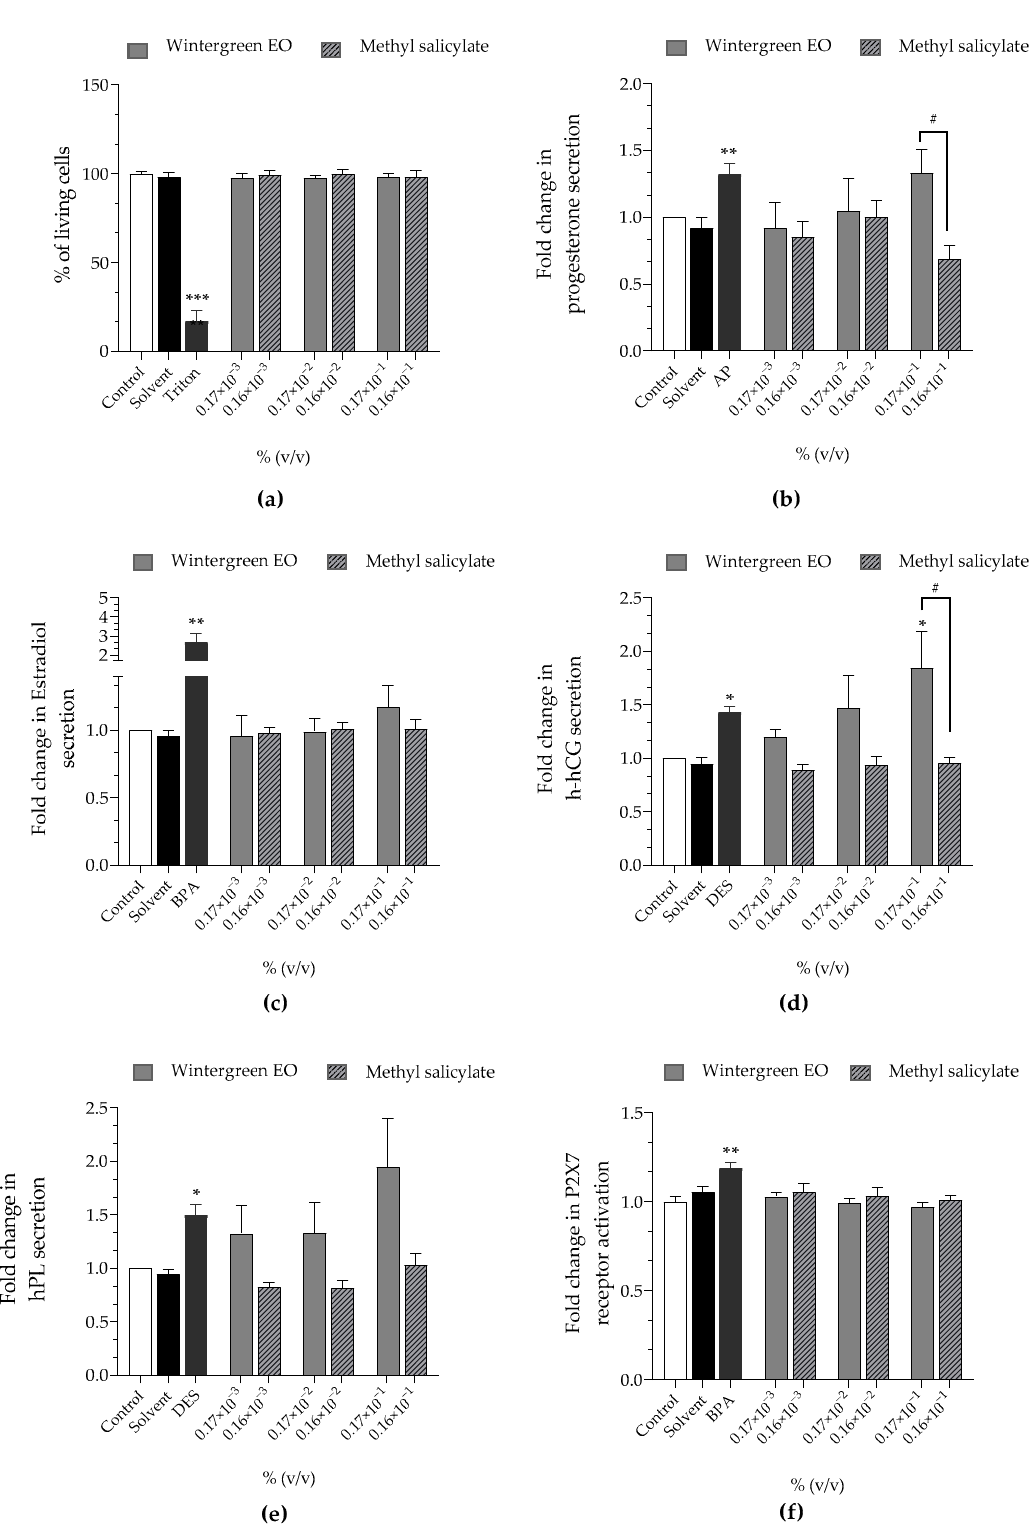
Figure 4. Effects of wintergreen EO and methyl salicylate on ( a ) cell viability (Alamar Blue assay), on released hormones: ( b ) progesterone ( c ) estradiol, ( d ) h-hCG, and ( e ) hPL and on ( f ) P2X7 receptor activation (YO-PRO-1 assay) were evaluated, after incubation of JEG-Tox cells for 72 h. Triton ® X-100 at 0.016%, bisphenol A (BPA) at 20 µ M, 4-tert-amylphenol (AP) at 10 µ M and diethylstilbestrol (DES) at 3.75 µ M are used as positive controls. The significance thresholds were * p < 0.1, ** p < 0.01, *** p <0.001 and # p <0.1.